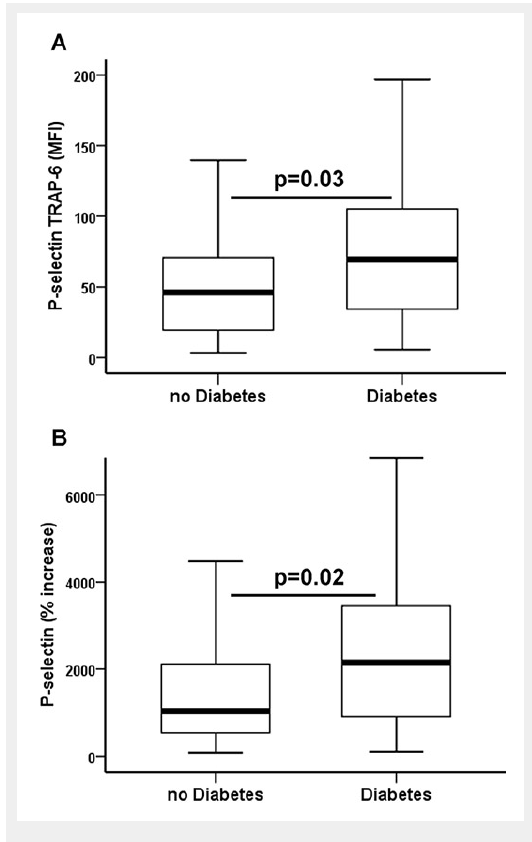
(A) Thrombin receptor activating peptide-6 (TRAP-6) inducible P- selectin (P-selectin TRAP-6) and (B) relative increase of platelet P- selectin (% increase) after activation with TRAP-6 in patients with coronary artery disease without and with type 2 diabetes. The boundaries of the box show the lower and upper quartiles of data, the line inside the box represents the median. Whiskers are drawn from the edge of the box to the highest and lowest values that are outside the box but within 1.5 times the box length. MFI = mean fluorescence